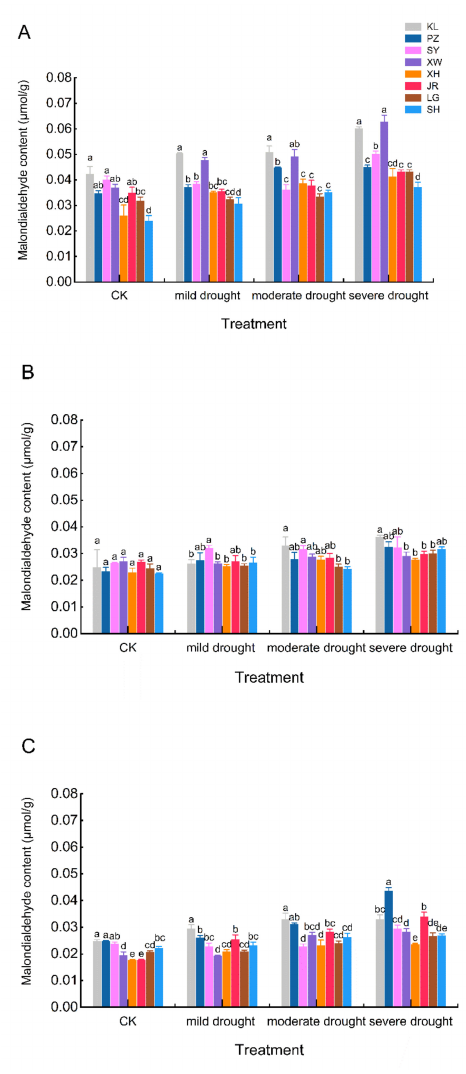
Figure 8. The malondialdehyde content of Melia azedarach among different provenances: ( A ): early stage, ( B ): middle stage, and ( C ): late stage. Note: The error line in the figure is the mean ± standard error, and different lowercase letters in the same treatment indicate significant differences at the 0.05